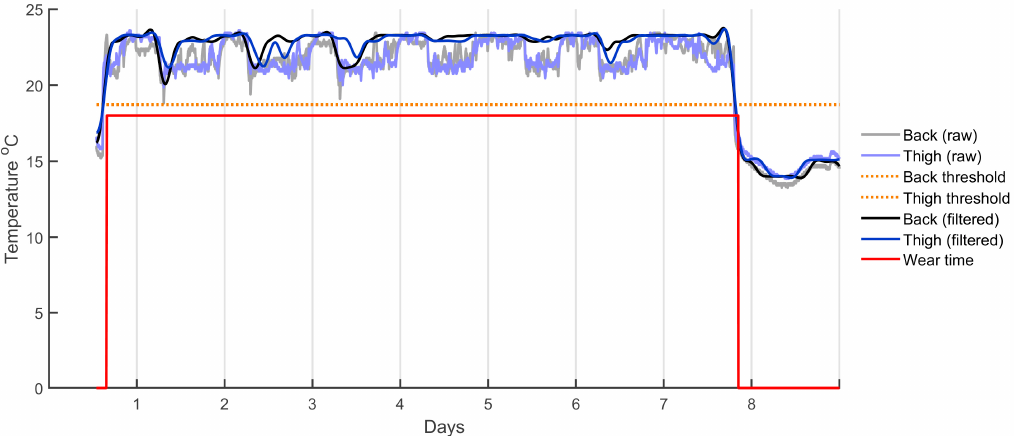
Figure 3. Example of temperature sensor outputs and wear time thresholds for paired Axivity AX3 accelerometers.